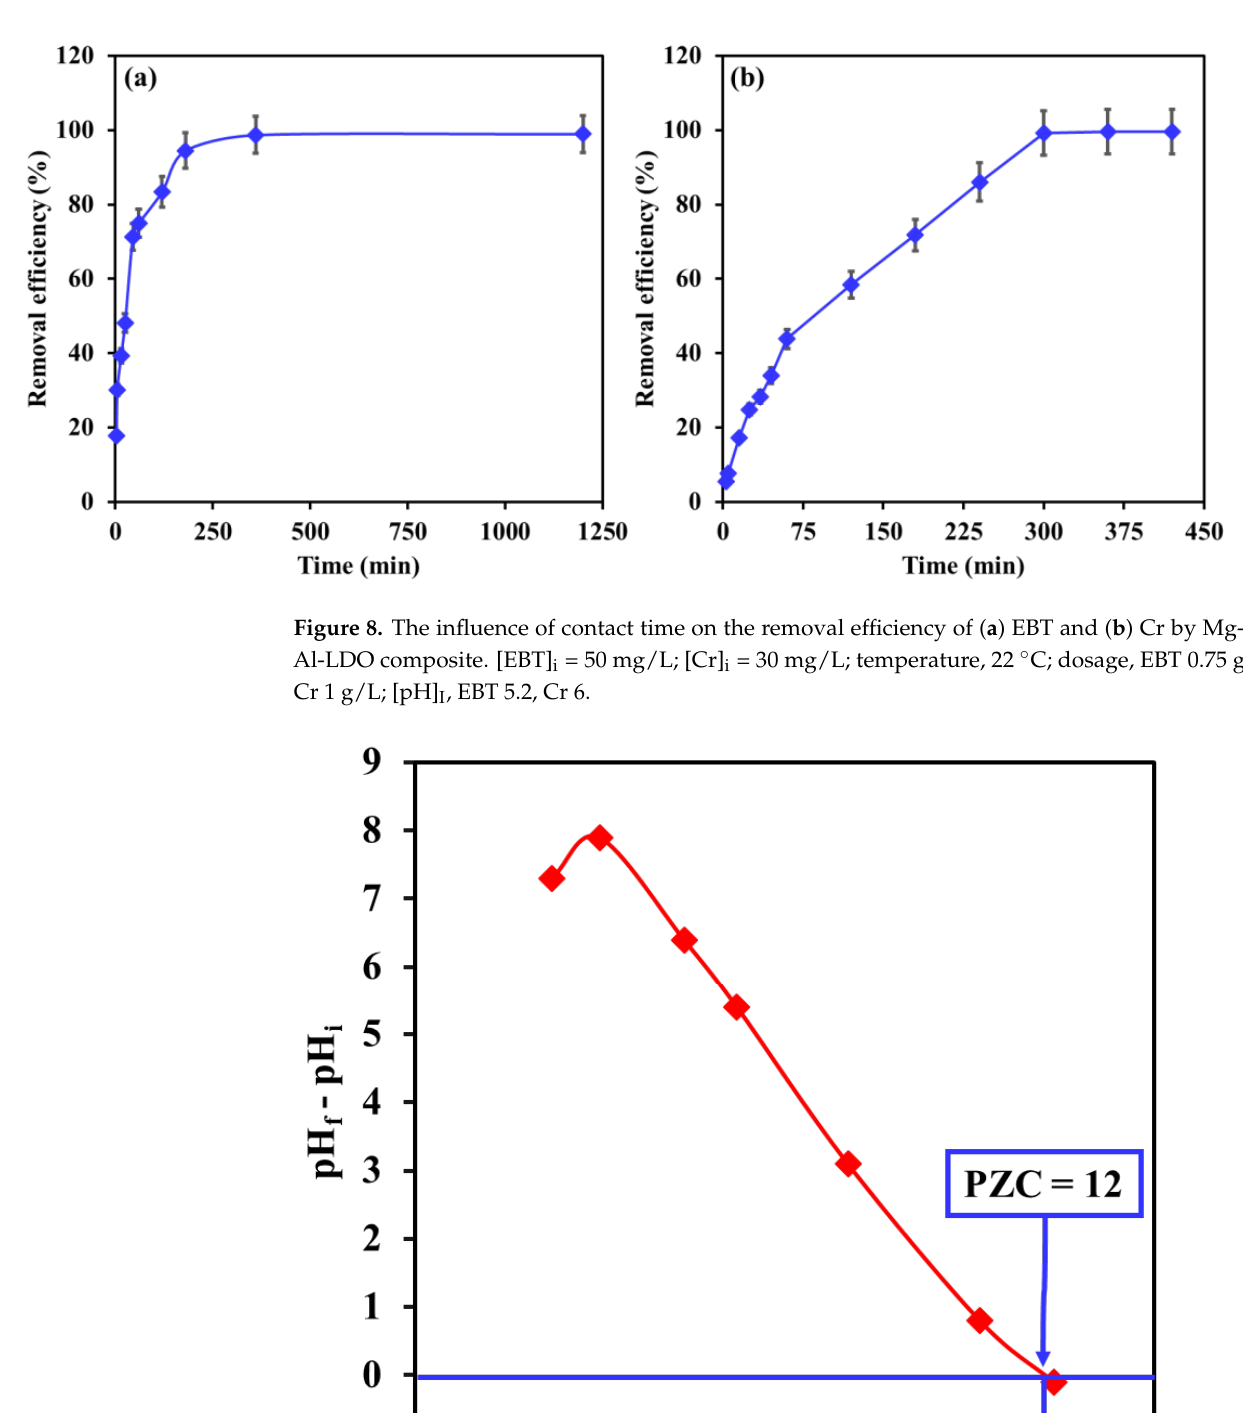
Figure 10. Influence of initial solution pH on the removal efficiency of EBT ( a ) and Cr ( b ) by Mg − Ca − Al − LDO composite. [EBT] i = 100 mg/L; [Cr] i = 30 mg/L; temperature, 22 °C; contact time, 24 h; dosage, EBT 0.75 g/L, Cr 1.25 g/L. 3.4. Influence of Temperature The influence of increasing the temperature from 22 °C to 60 ℃ on the adsorption capacity of Mg-Ca-Al-LDO composite for EBT and Cr is illustrated in Figure 11. The re- sults demonstrate a reduction in the adsorption capacity of the Mg-Ca-Al-LDO toward EBT from 65.8 mg/g to 62.7 mg/g by raising the temperature from 22 °C to 60 °C. In con- trast, the adsorption capacity of the Mg-Ca-Al-LDO for Cr was found to slightly increase from 29.0 to 29.8 mg/g by increasing the temperature from 22 °C to 60 °C. These outcomes suggest an exothermic adsorption process for EBT and an endothermic adsorption process for Cr by Mg-Ca-Al-LDO composite. However, the maximum reduction in the adsorption capacity of the Mg-Ca-Al-LDO for EBT was less than 5%, while the enhancement in Cr